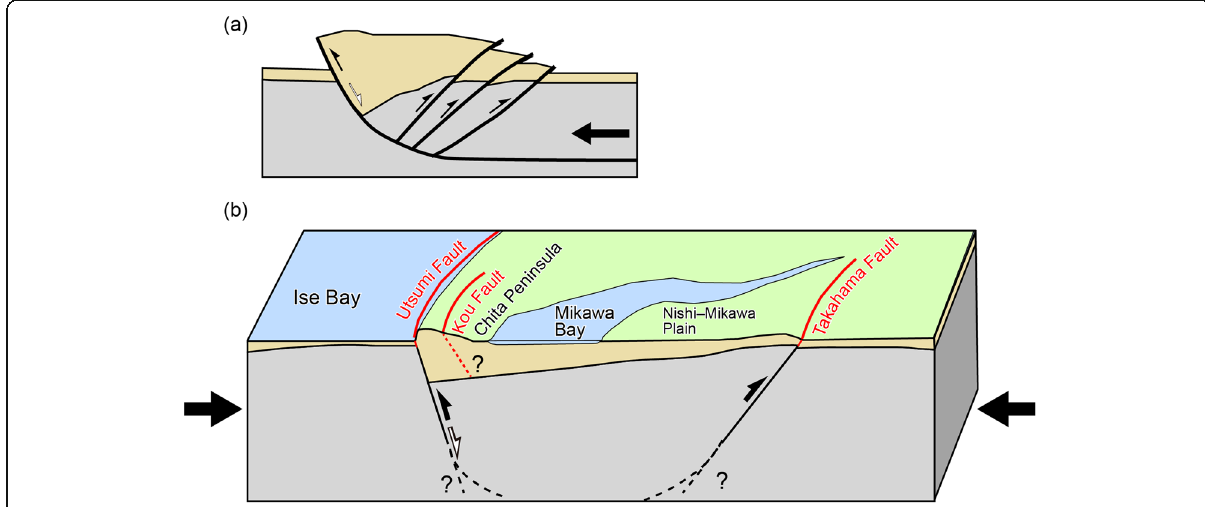
Fig. 11. a Conceptual models for thrust faults developed by the dip-slip inversion of a normal fault system (modified after McClay and Buchanan 1992). The white arrow represents normal faulting during the extensional stage. Black arrows indicate reverse faulting during the compressional stage following the extensional stage. b Conceptual models for the fault system across the Chita Peninsula and the Nishi – Mikawa Plain (not to scale). The white arrow represents the normal faulting in the extensional stage in Miocene. Black arrows indicate reverse faulting during